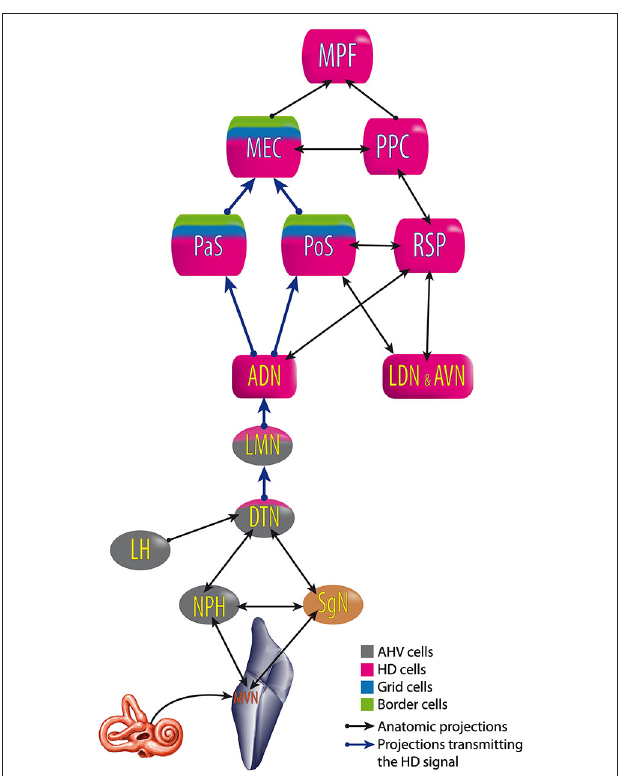
FIGURE 6 | Head Direction pathway . ADN, anterodorsal thalamus; AVN, anteroventral thalamus; DTN, dorsal tegmental nucleus; LDN, laterodorsal thalamus; LMN, lateral mammillary nuclei; MEC, medial entorhinal cortex; MPF, medial prefrontal cortex; MVN, medial vestibular nuclei; NPH, nucleus prepositus hypoglossi; PaS, parasubiculum; PoS, postsubiculum; PPC, posterior parietal cortex; RSP, retrosplenial cortex; SgN,